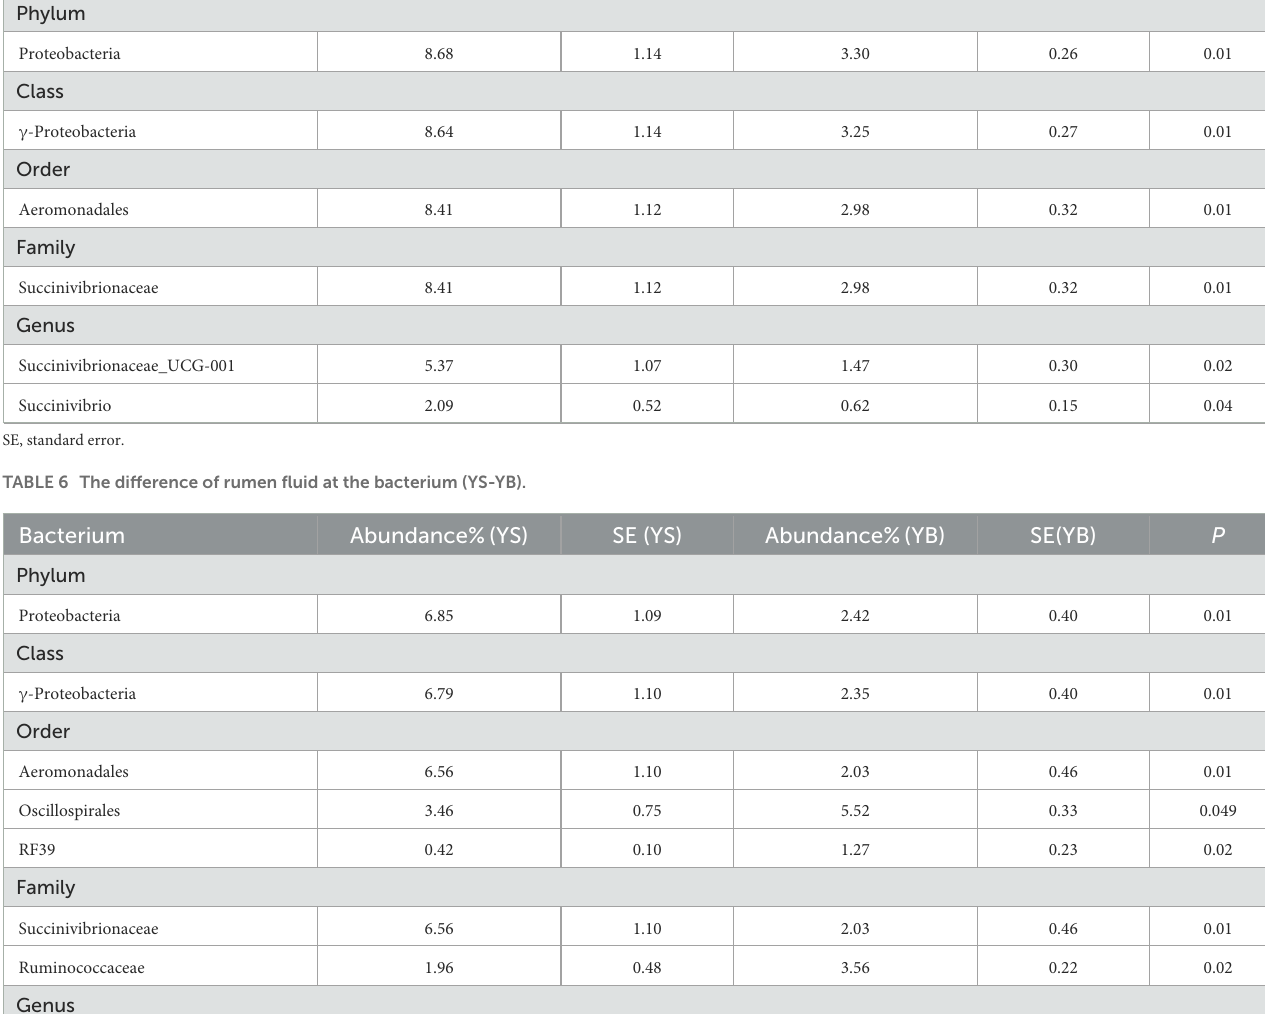
TABLE 5 The difference of rumen fluid at the bacterium (XS-XB). Bacterium